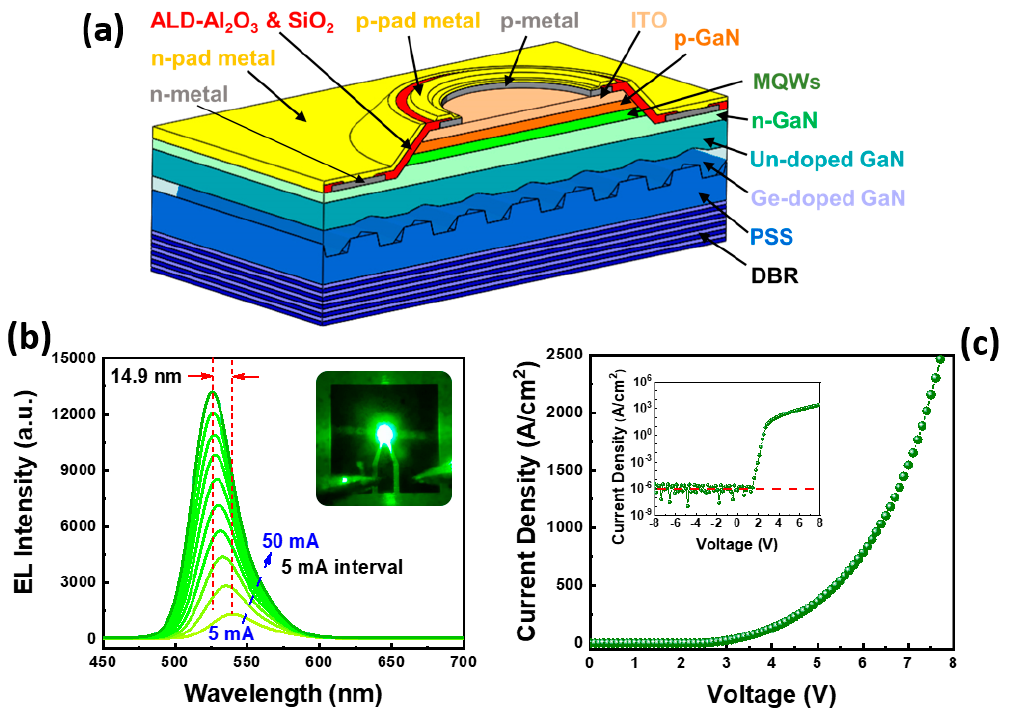
Figure 4. ( a ) Schematic diagram of (20-21) µ -LED structures; ( b ) electroluminescence (EL) spectra at different currents and an image of lighting from the device; (c) Current density-Voltage (J–V) curve of the semipolar µ-LEDs. [60] Figures reproduced with permission from ACS Publications.